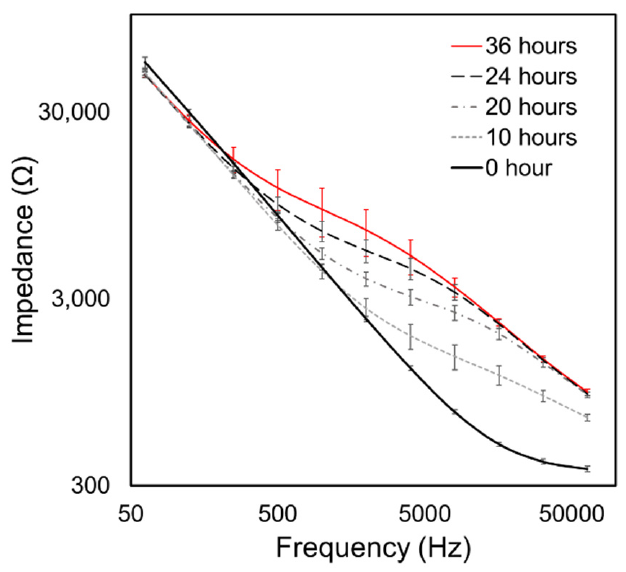
Figure 4. The evolution of Impedance vs. Frequency throughout the culturing period of 36 h. Error bars are standard deviations of data from n = 8 electrode arrays in the flow chamber. Our results are similar to evolution patterns by [17]. The initial spreading period occurs over t < 10 h, leading to the impedance increasing over 10 kHz < f < 64 kHz. Subsequently ( t > 20 h), the impedance of the middle frequency region (1 kHz < f < 10 kHz) elevates, which represents formation of cell–cell binding.